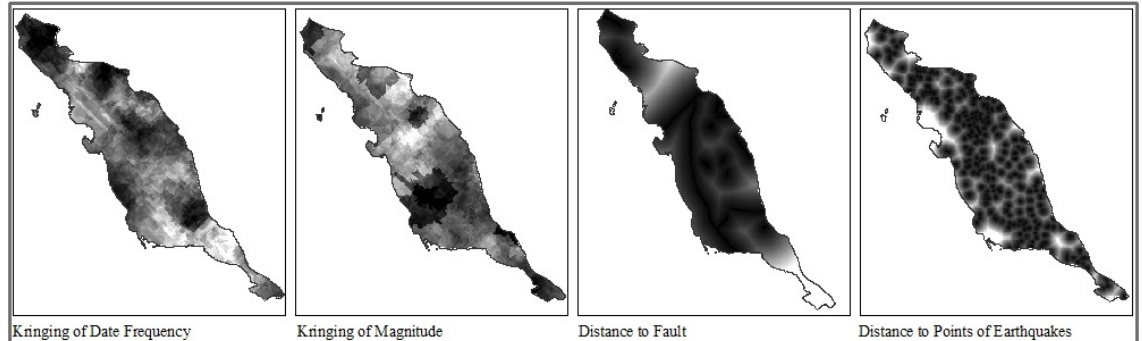
Figure 2: This is an illustration of the four criteria. White areas show higher pixel values and the dark portions represent the lower pixel values by their own units of measurement. 3.